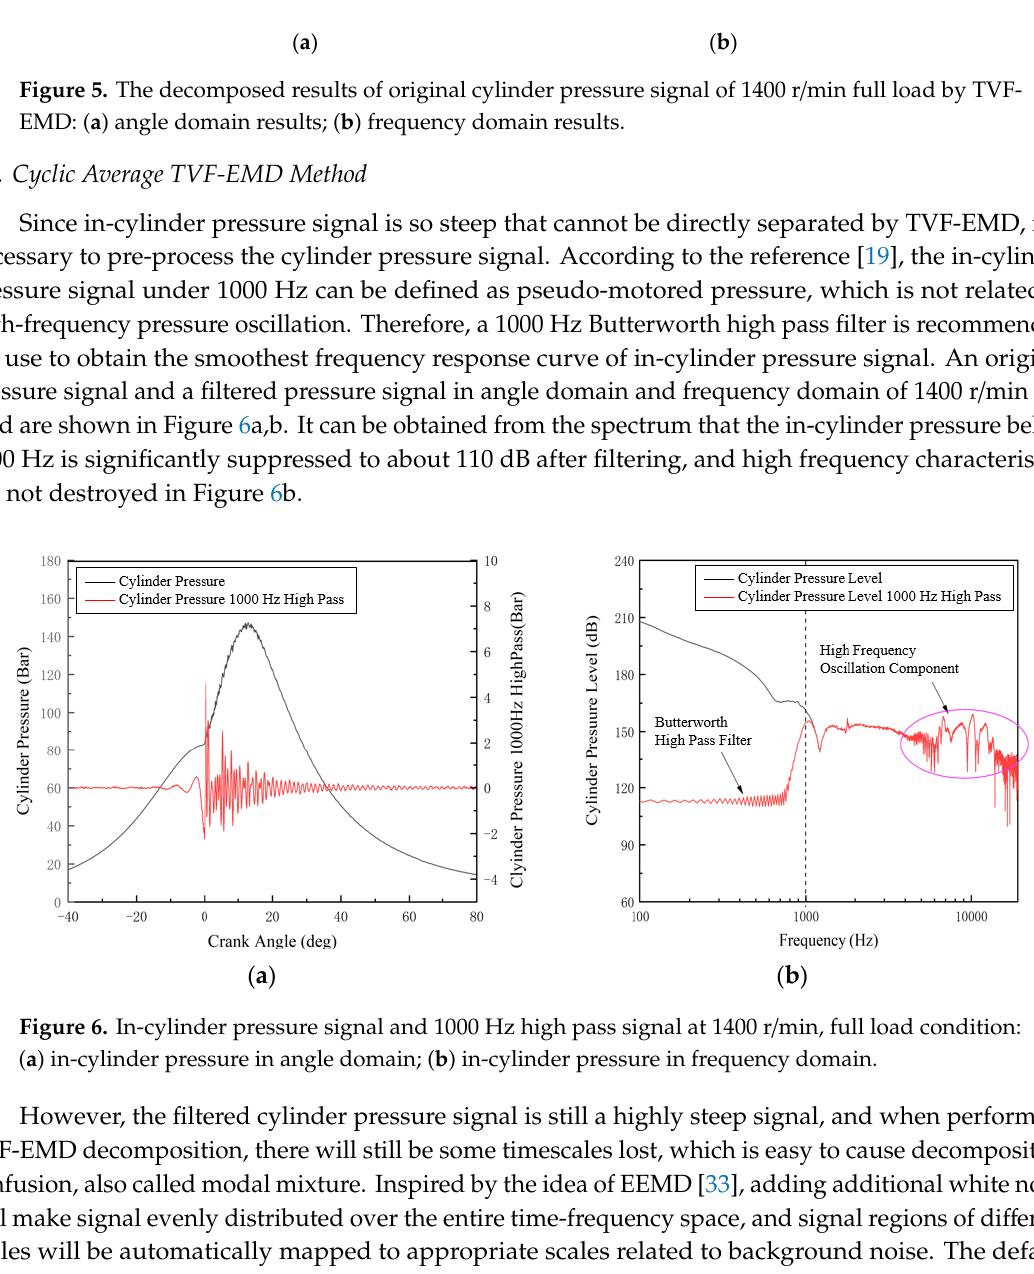
Figure 5. The decomposed results of original cylinder pressure signal of 1400 r/min full load by TVF- EMD: ( a ) angle domain results; ( b ) frequency domain results.